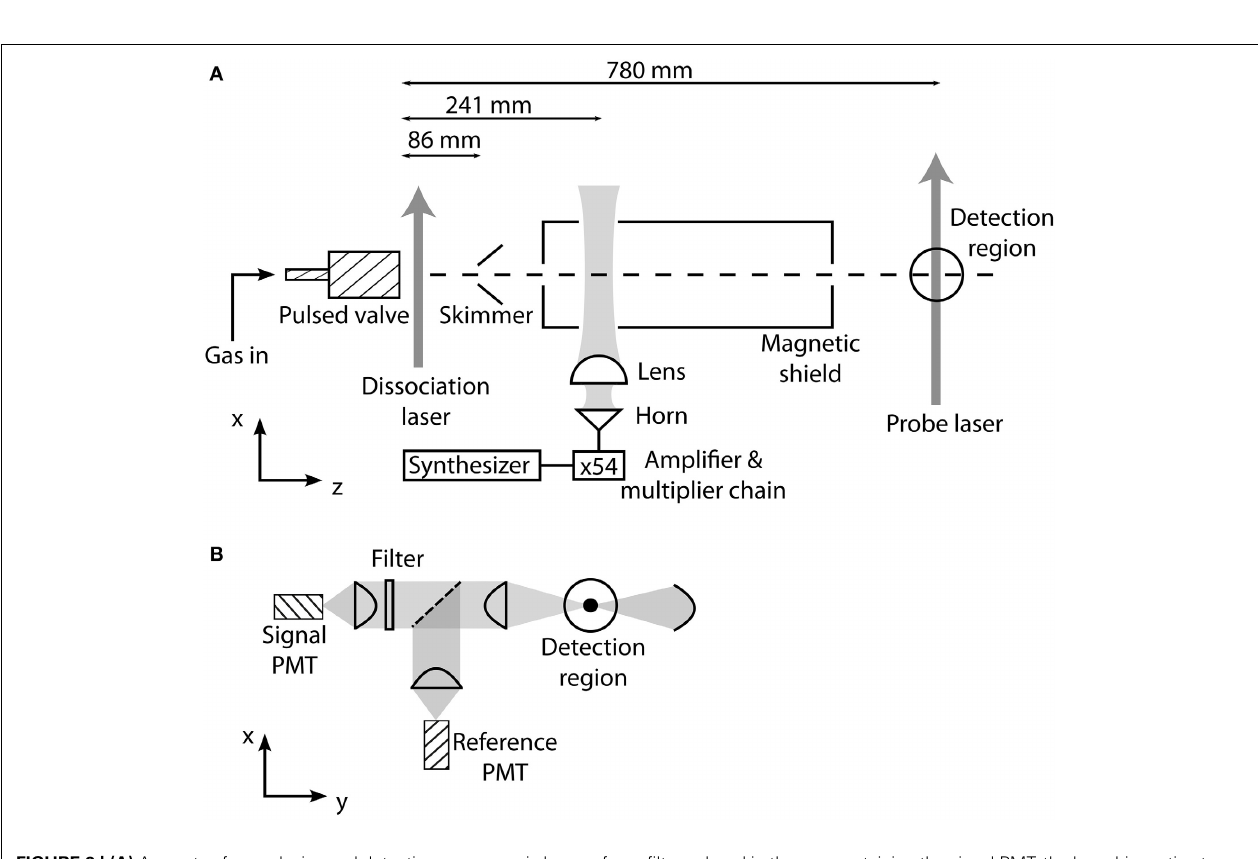
filters placed in the arm containing the signal PMT, the branching ratios to various vibrational states is determined. The reference PMT is used to account for fluctuations in molecular